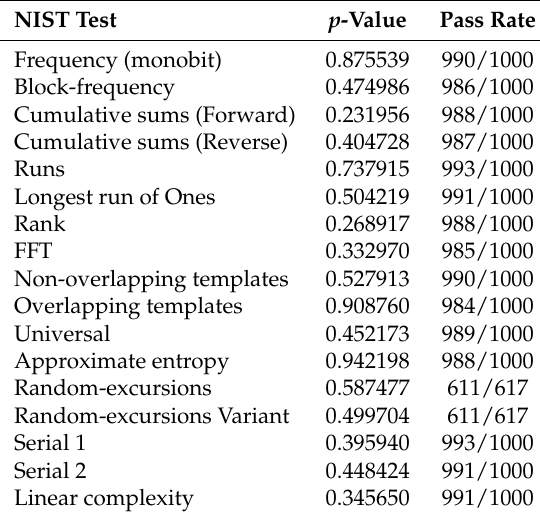
Table 1. NIST test suite